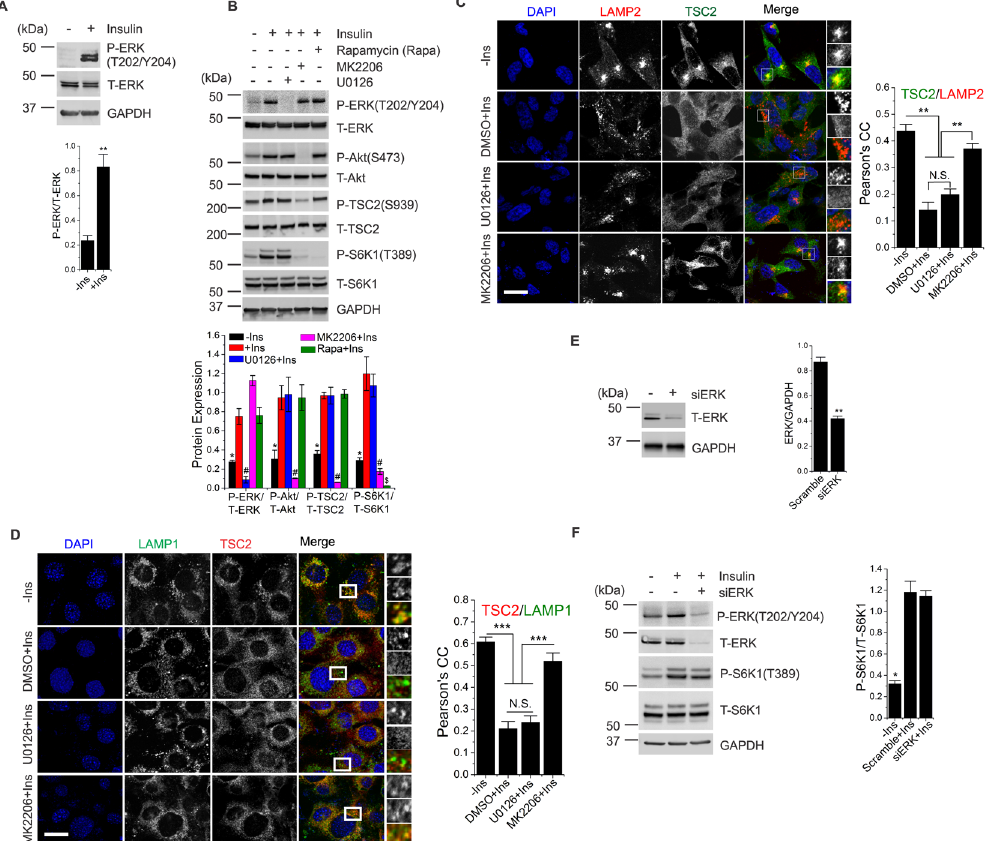
Figure 1. Insulin regulation of ERK and Akt/mTORC1 are independent of each other. ( A ) HEK cells were starved of serum (16 h) prior to insulin stimulation (1 µ M, 15 min). Cell lysates were probed with antibodies as indicated. Quantification of three independent experiments is reported in the bar diagrams. ( B ) HEK cells were starved of serum (16 h) and treated with indicated drugs for 2 h prior to insulin stimulation (1 µ M, 15 min). Lysates were analyzed by immunoblot assay using antibodies as indicated. Quantification of three independent experiments is reported in the bar diagrams. * , # and $ indicate significant differences between all conditions in each group. ( C ) HEK cells were treated as in B prior to immunofluorescent labeling of endogenous LAMP2 (red) and TSC2 (green). Bar indicates 30 μ m. ( D ) Tsc2 + / + MEFs were treated as in B prior to immunofluorescent labeling of endogenous LAMP1 (green) and TSC2 (red). Bar indicates 20 μ m. Representative cells are shown in C and D , where yellow or orange pixels indicate co-localization in the merged images. Zoomed images represent the area under the white box. Quantification of three independent experiments and at least 30 cells is reported in the bar diagrams in C and D . ( E ) HEK cells were transfected with siRNA targeted to ERK (or scrambled controls) for 72 h prior to cell lysis. Lysates were probed with antibodies as indicated. ( F ) HEK cells transfected with siERK or scramble for 56 h prior to 16 h-serum starvation followed by insulin stimulation (1 µ M, 15 min) where indicated. Lysates were probed with antibodies as indicated. Quantification of three independent experiments is reported in the bar diagrams in E and F . All quantitative analyses are reported as mean ± SEM with a significance level of * p < 0.05, ** p < 0.01, *** p < 0.001, # p < 0.05 and $ p < 0.01. N.S. indicates not significant. GAPDH was used as a loading control in all immunoblot assays. Cropped blots from full-length gels are displayed in A , B , E and F